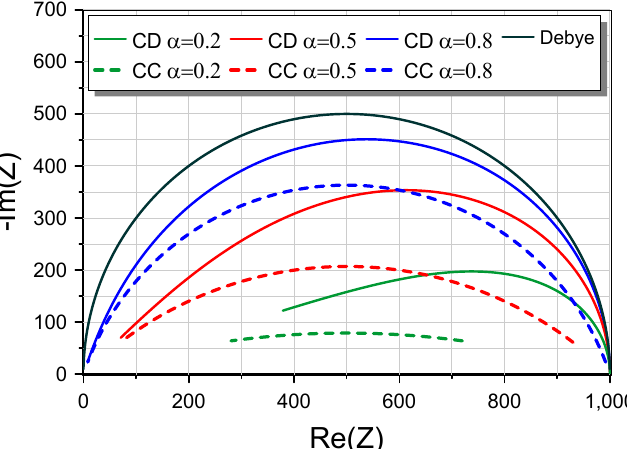
Figure 1. Nyquist plots of the Cole–Cole (CC) and Cole–Davidson (CD) impedance functions for α = { 0.2, 0.5, 0.8 } over the frequency range f = [100,1M]Hz with τ = 1/ ( 2 π f 0 ) = 628.3 µ s and Z 0 = 1k Ω